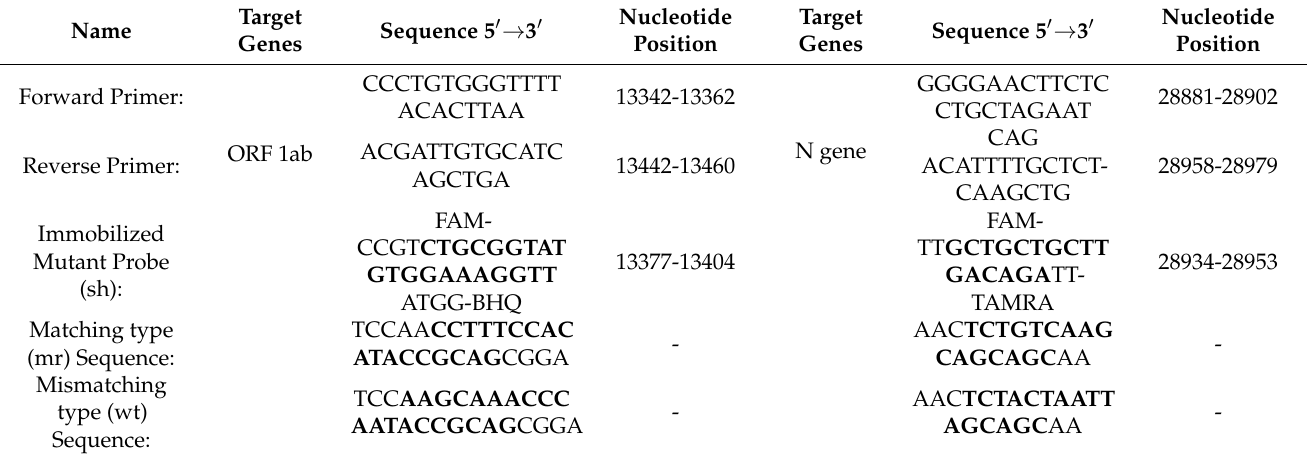
Figure 12. Schematic diagram of ( a ) SPR and ( b ) SPRF curve characteristics of Bk 7 /Au(50 nm)/PtSe 2 (2 nm)/Graphene (0.34 nm × L) substrates without probe (sh-Oligo), with sh-Oligo and different concentrated levels of oligonucleotide (wt or mr type) binding for recognition of SARS-Cov-2 virus RNA. θ SPR angle and SPRF shift right due to binding with oligonucleotides. Table 7. Primers and probe sequence orientation for recognition of SARS-CoV-2 virus RNA.